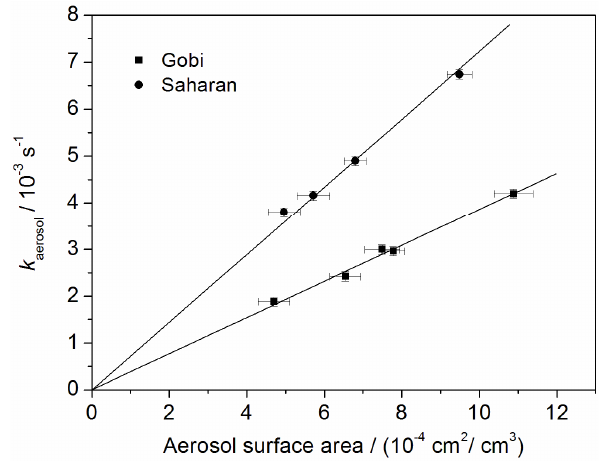
Fig. 5. Variation of uptake coefficients for H 2 O 2 with relative hu- midity for the Gobi and Saharan dust samples. Error bars are 2 σ Figure 5. Variation of uptake coefficients for H 2 O 2 with relative humidity for the Gobi and 3 statistical. The additional data points at 35% RH for both dusts are Saharan dust samples. Error bars are 2 σ statistical. The additional data points at 35% RH for 4 calculated from the data shown in Fig. both dusts are calculated from the data shown in Fig. 4. 5 g = (6.76 ± 0.22) × 10 -4 for the 5 22 OH